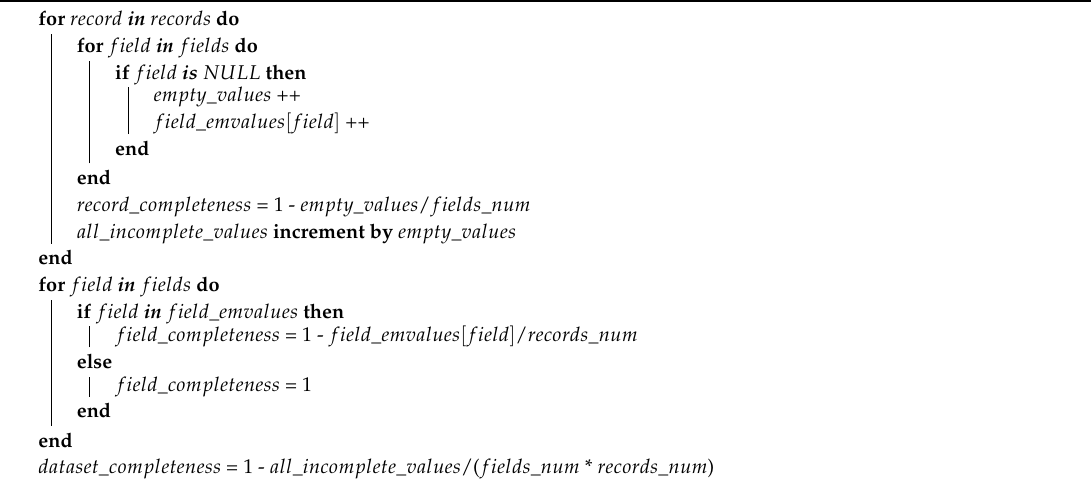
Algorithm 1: Pseudocode of completeness measurement for source metadata